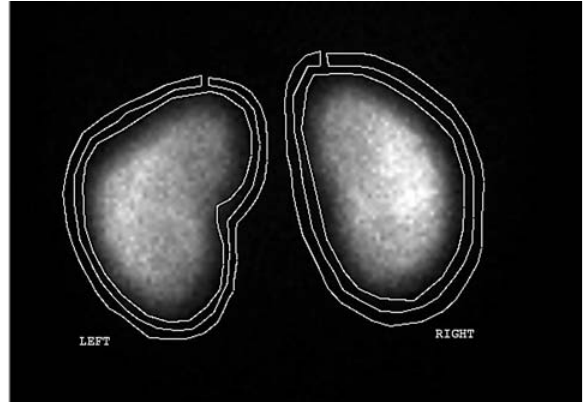
Figure 2 – Renal regions of interest (ROIs) drew manually in the posterior image of 99mTc-DMSA scintigraphy and background regions of interest (ROIs) drew automatically by the processing